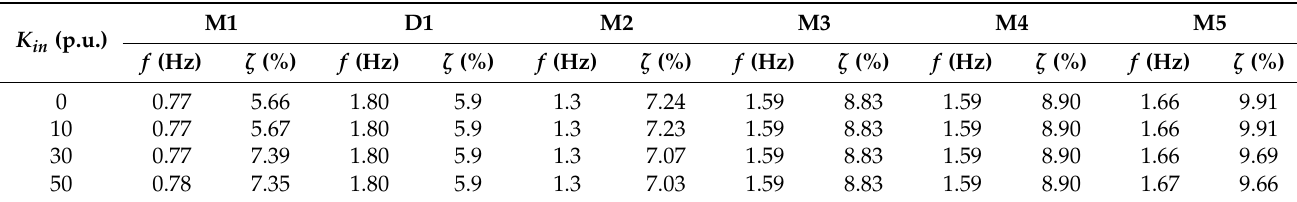
Table 14. Effect of increasing SI contribution from FCWTs on the modes of the High Import DP. K in (p.u.)